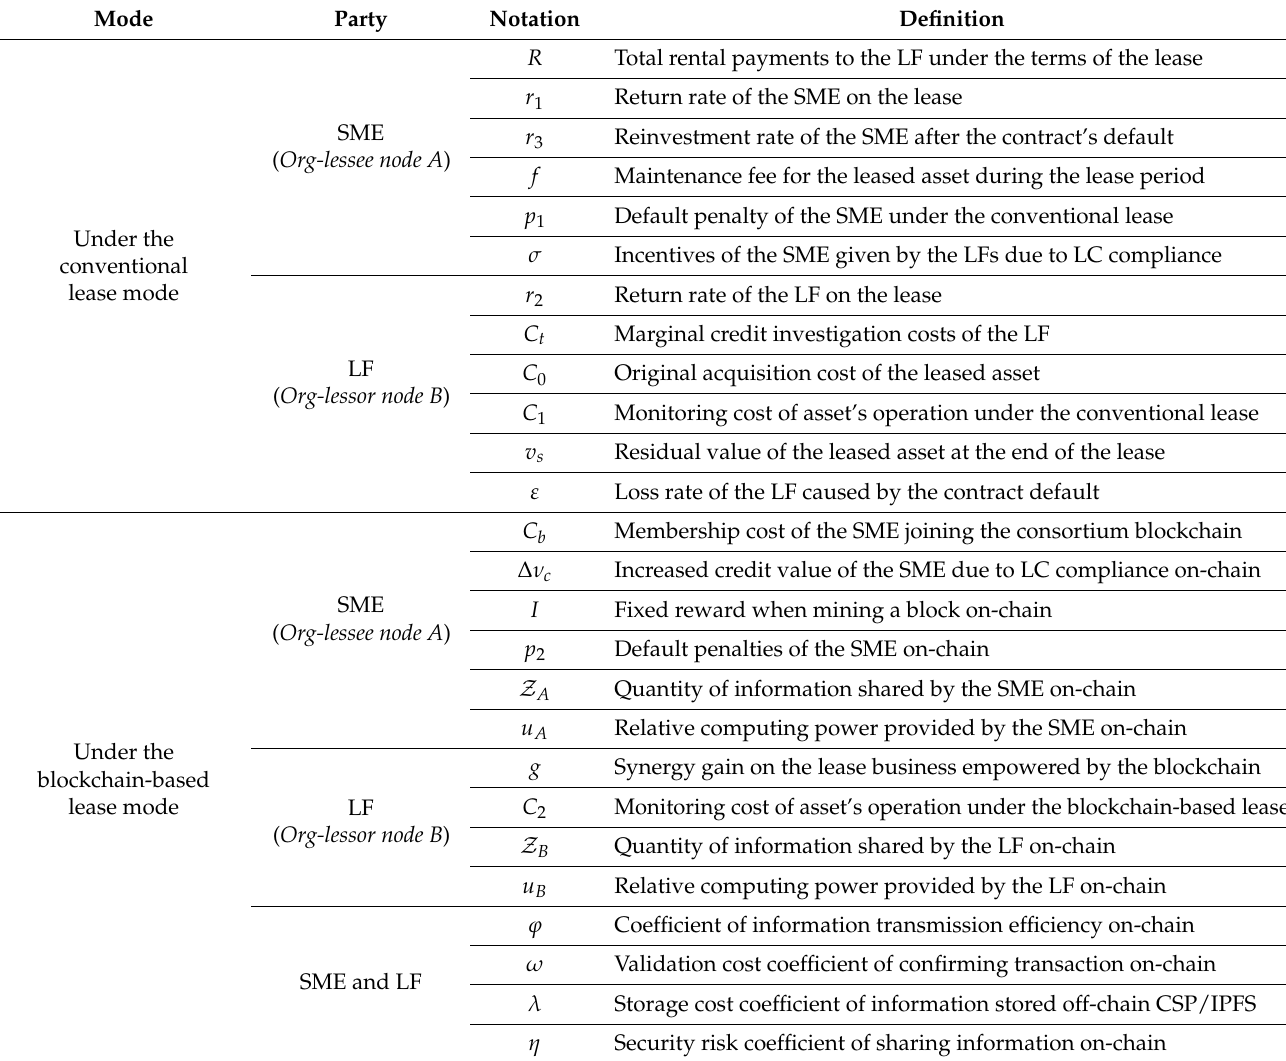
Table 1. Parameters. Explanation under the conventional/blockchain-based lease